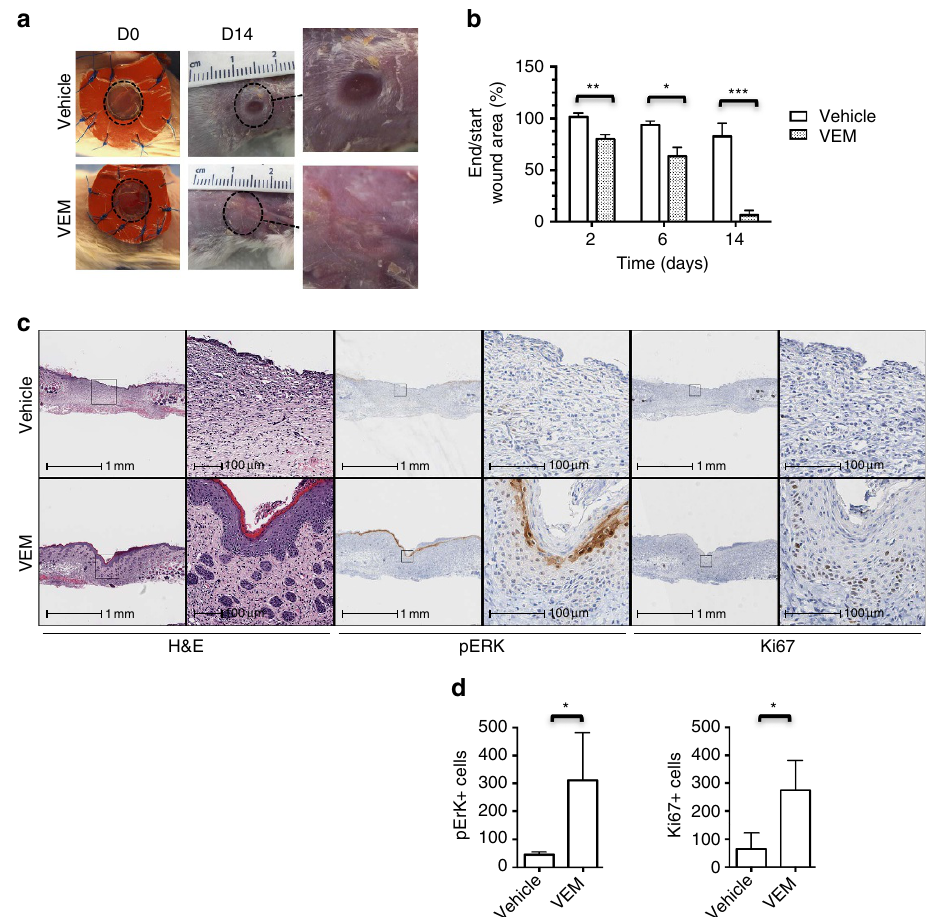
Figure 3 | BRAF inhibition accelerates wound healing in an excisional wound model. ( a ) Representative images of vehicle-treated and vemurafenib (VEM)-treated mice on day 0 and day 14. Original wound area is marked with dotted circles and amplified on the right side. ( b ) Percentage of wound closure on day 2, 6 and 14. (** P ¼ 0.004 ( n ¼ 6), * P ¼ 0.02 ( n ¼ 4; two mice died due to haemorrhagic wounds), *** P ¼ 0.0002 ( n ¼ 6)). ( c ) Representative photomicrograph hematoxylin and eosin (H&E), pERK and Ki67 staining images in the presence and absence of vemurafenib by day 14. ( d ) Bar graph representing the quantification of pERK þ and Ki67 þ cells in the vehicle- and vemurafenib-treated wounds on day 14 (* P ¼ 0.02; n ¼ 4). Error bars in b and d , mean ± s.d. Bar graphs represent one experiment with 4 to 6 replicates per